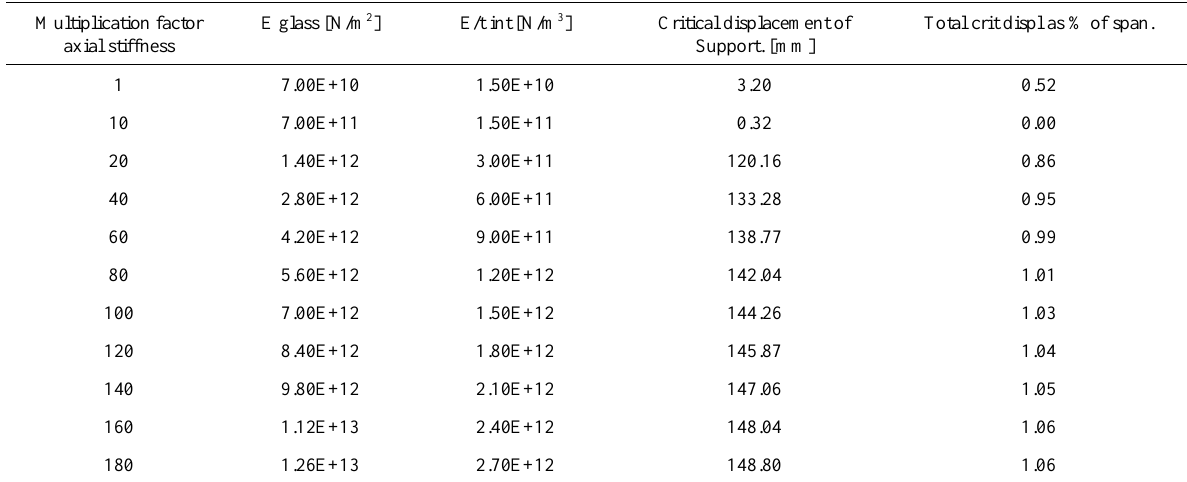
Table 4 Results increasing axial stiffness for t=800mm model